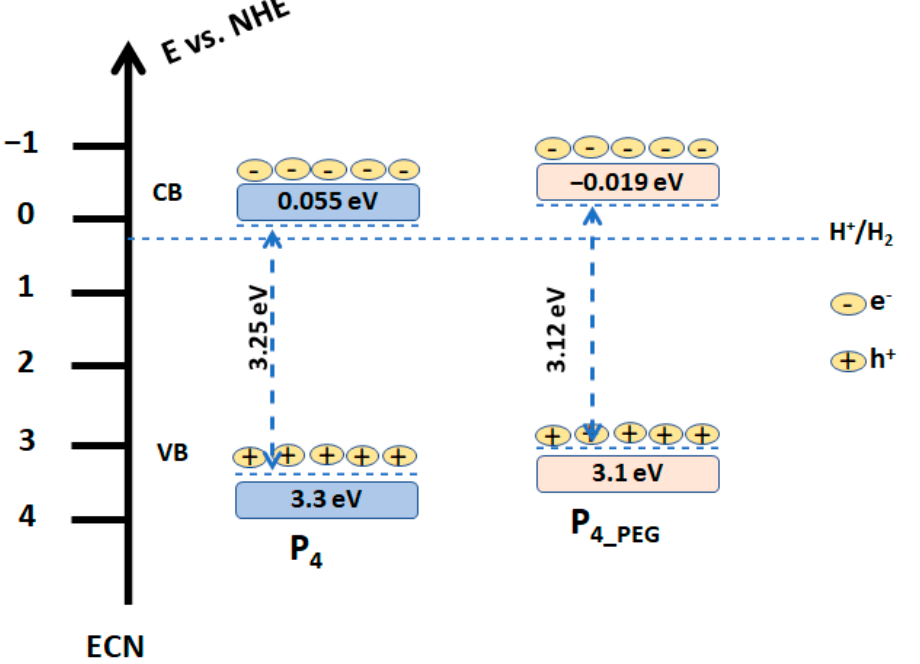
Figure 12. Schematic diagram of the band gap of the P 4 and P 4_PEG .